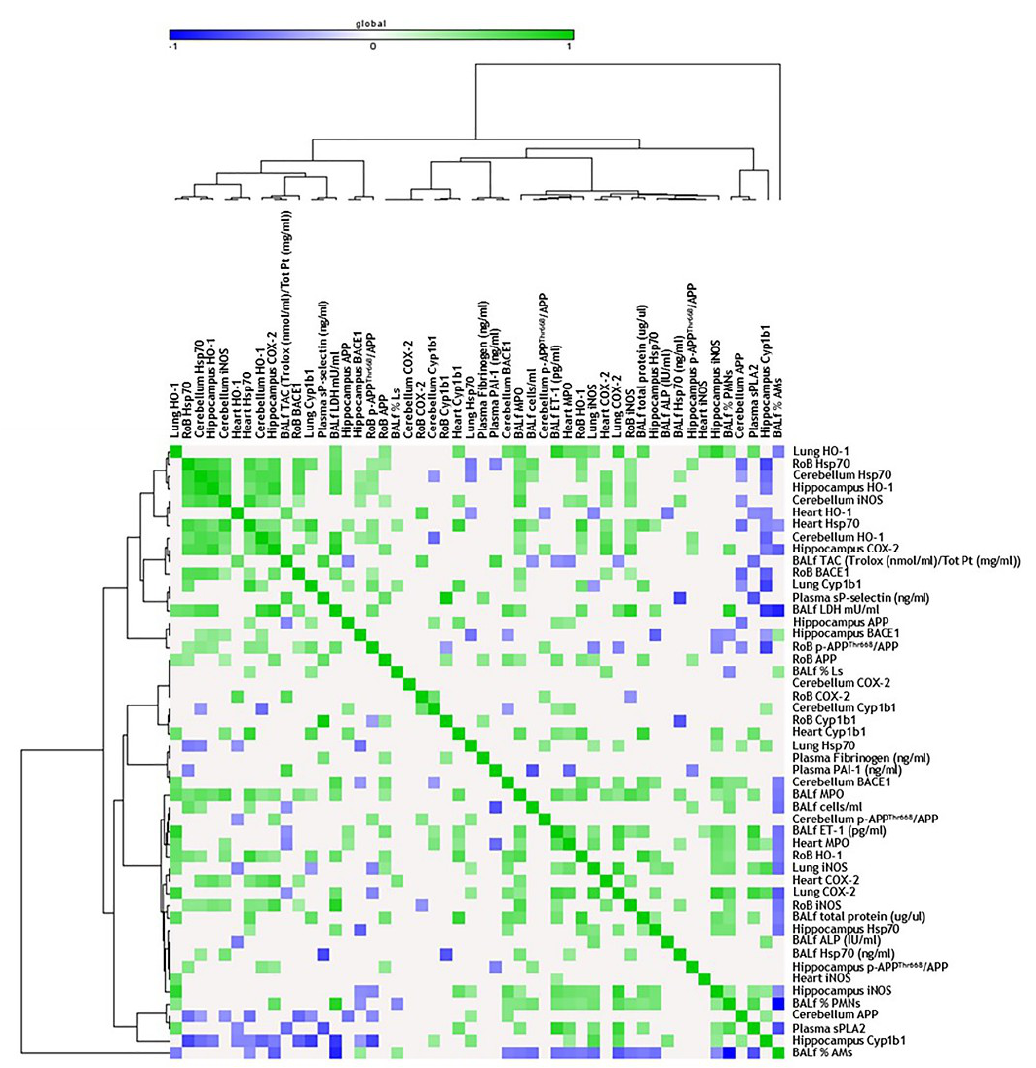
Figure 4. Correlation analysis in acute treatment. Heat map showing the Pearson correlation between markers expressed in the rest of brain (RoB), cerebellum, hippocampus, and respiratory and cardiovascular system markers assessed in the same animals and presented in our previous work [33], after a single instillation with 50 μg of BB or DEP/100 μL 0.9% NaCl. All the correlation data are reported in Table S1 (Supplementary Materials).